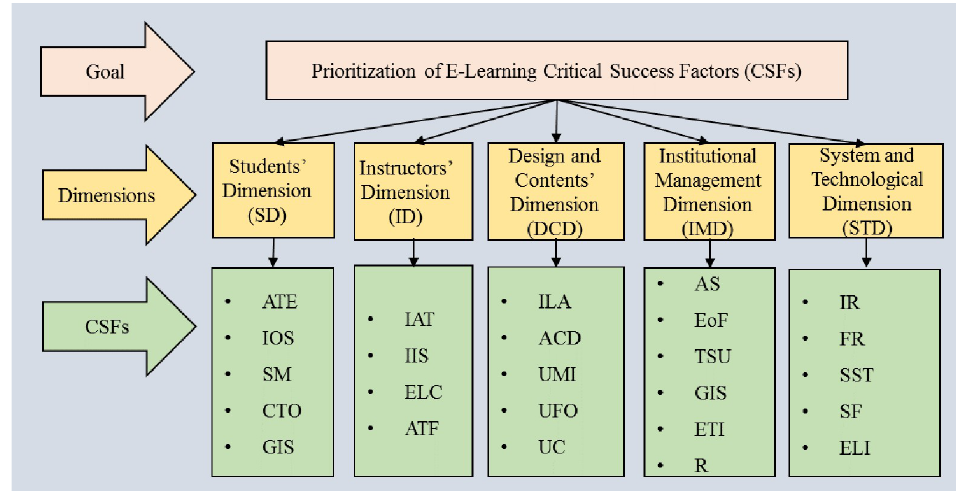
Fig 4. Hierarchical structure for dimensions and CSFs of E-Learning